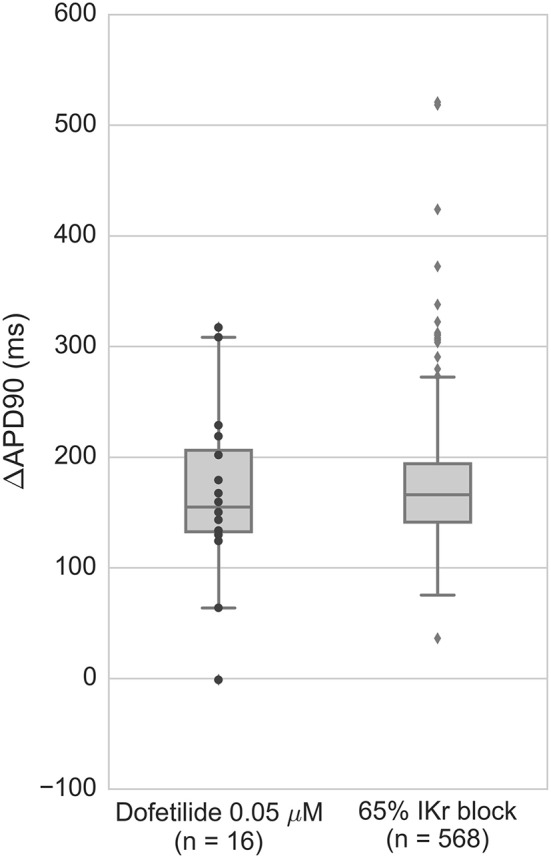
APD prolongation of ventricular preparations under 0.05 μM dofetilide (n = 16) compared to population of models under 65% IKr block, corresponding to the effects of 0.5 μM dofetilide using IC50 and Hill coefficient determined by Kramer et al. (2013). Models displaying repolarization abnormalities (7/568 models) were excluded from the figure. Black dots are experimental data points, gray dots are outliers (>1.5 times interquartile range from the nearest inner quartile).